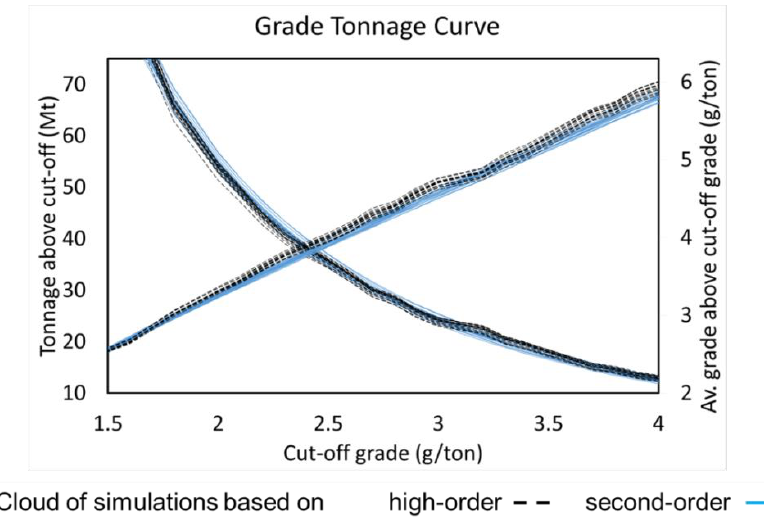
Figure 2. The grade-tonnage curve of the gold deposit for SGS (second-order) and high-order simulations.